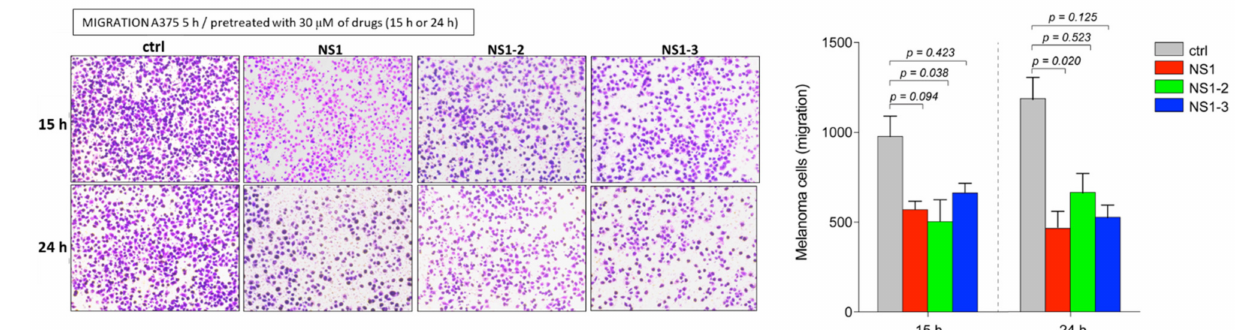
Figure 5. Migration of A375 cells treated or not with NS1. Left panel: Serum-stimulated migration assays were performed in Boyden chambers. A total of 100,000 A375 melanoma cells were incubated with NS1 or its separated isomers (30 µ M) or with control for 15 h or 24 h. Then, the pre-treated cells were plated in the upper chamber in serum-free medium, while the lower chamber contained culture media with 10% serum to stimulate migration for 5 h. Representative images of the lower surface of membranes are shown; the two incubation times were expected to yield similar results due to a fast penetration (within minutes) of NS1 in cells, and likely reflect the experimental variation. Right panel: the mean migration of the cells is shown in triplicates from two independent experiments; error bars, SEM. p -values indicate the difference between the migration of control cells and the treated cells and were calculated by the Kruskal Wallis test with Dunn’s post-test (GraphPad Prism).